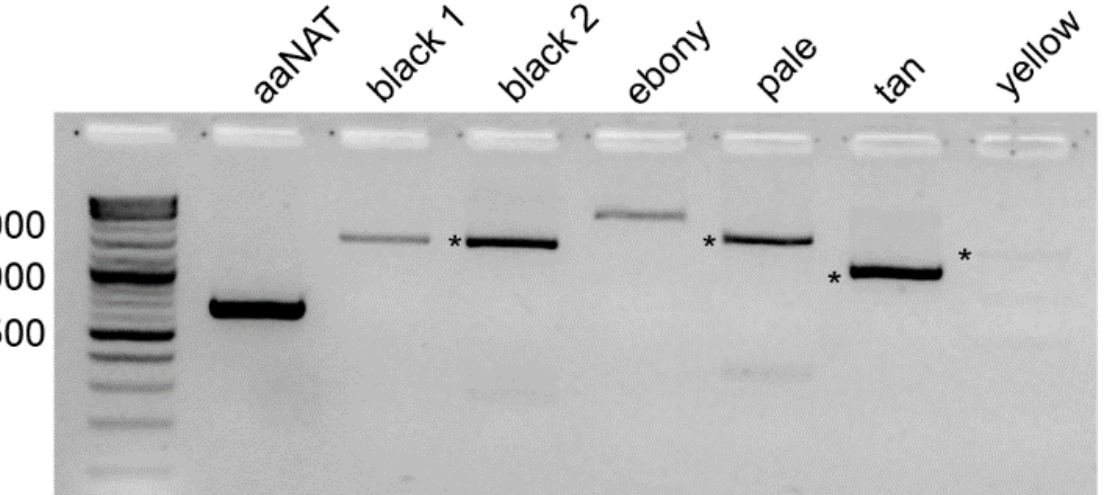
Figure 3. RT-PCR amplification of melanin pathway transcripts. Products were generated from mature adult body cDNAs using primers designed to amplify complete open reading frames. Expected sizes are: aaNAT —669 bp; black1 —1455 bp; black2 —1542 bp; ebony —2343 bp; pale —1680 bp; tan —1131 bp; and yellow —1320 bp. In lanes with multiple bands, products of the expected sizes are marked with an asterisk. All products were subcloned and sequenced.